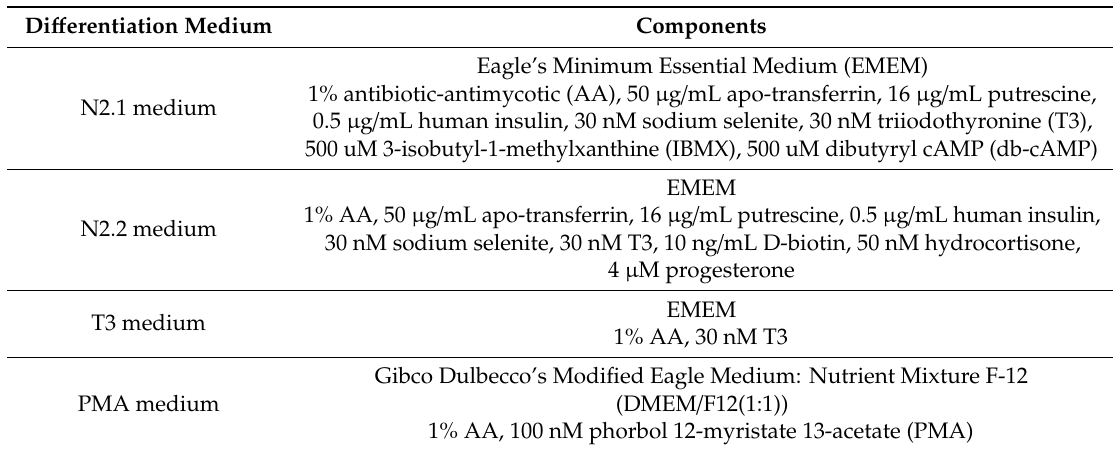
Table 1. Di ff erentiation media used in HOG and MO3.13 cell culture experiments. AA: antibiotic-antimycotic. db-cAMP: N6,2 (cid:48) -O-Dibutyryladenosine 3 (cid:48) ,5 (cid:48) -cyclic